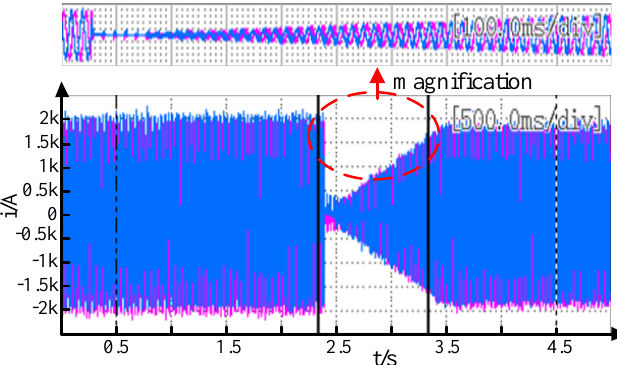
Figure 18. 40 MVar to − 40 MVar output two-phase current waveform.